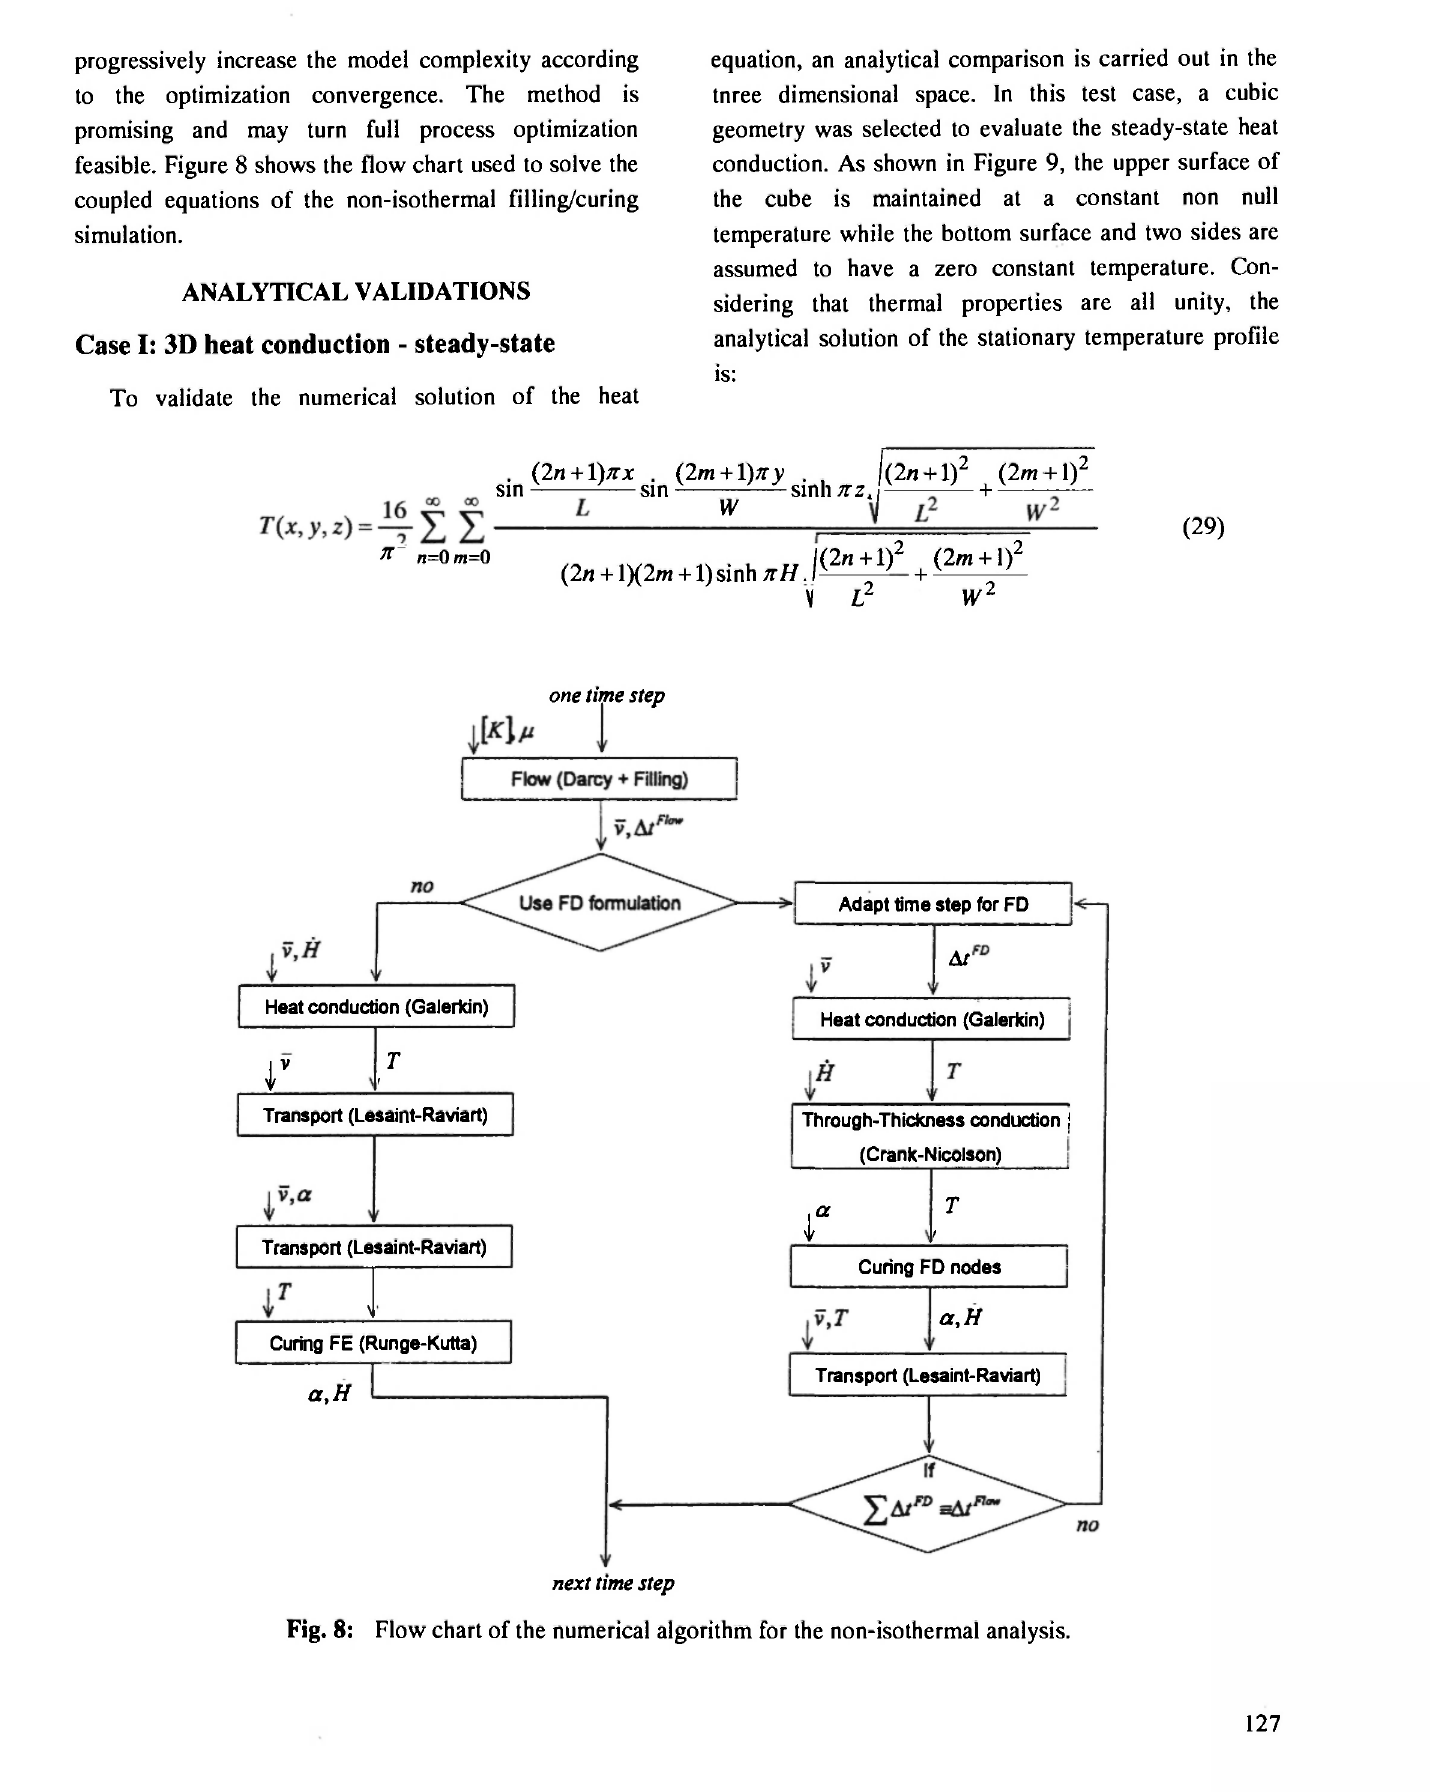
Flow chart of the numerical algorithm for the non-isothermal